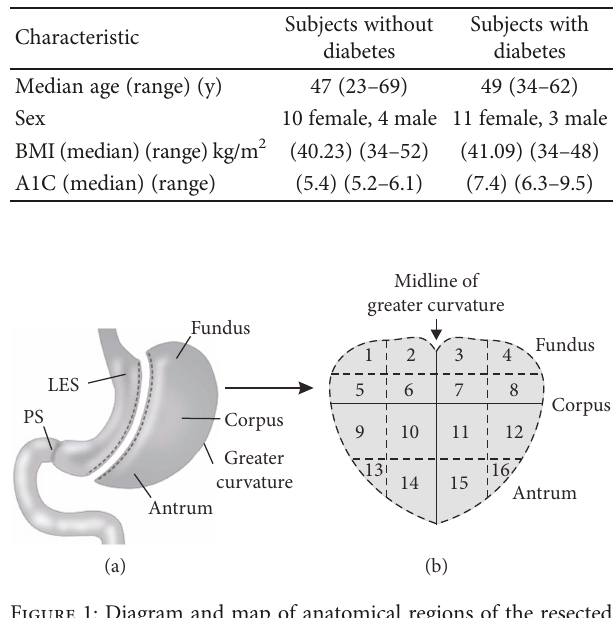
Subjects without Subjects with diabetes diabetes